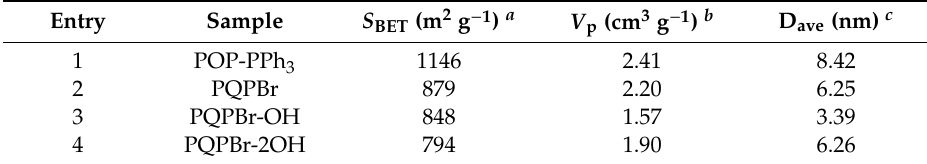
Table 1. Textural properties and Br – contents of the prepared catalysts.